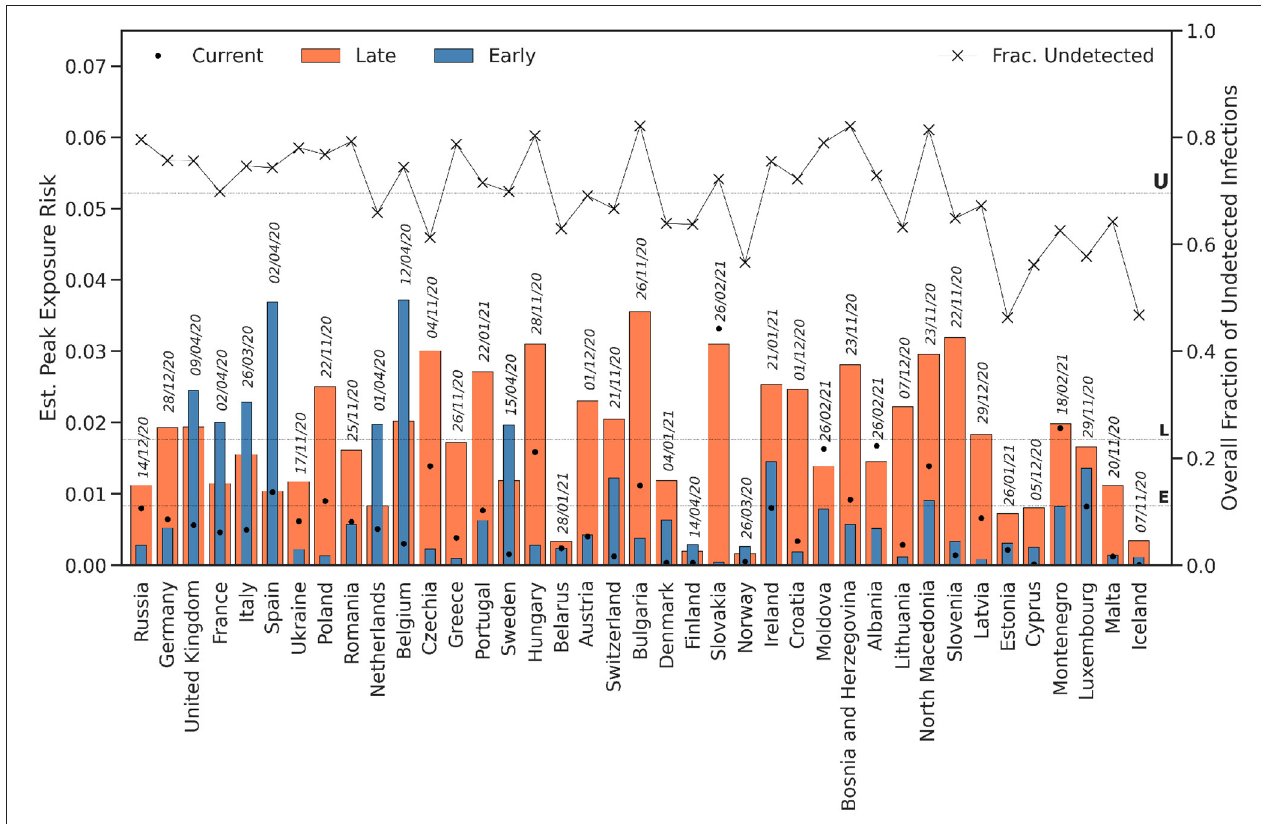
FIGURE 4 | The peak exposure risk (bars) for the early and late periods, and the current exposure risk, for countries in Europe. The line graph presents the average fraction of undetected infections for each country during the pandemic so far. The horizontal lines correspond to the mean (peak) exposure risks—for the early ( E ) and late ( L ) periods—and the mean fraction of undetected infections ( U ). The dates annotating the bars indicate the date of the peak exposure risk for that country for the pandemic so